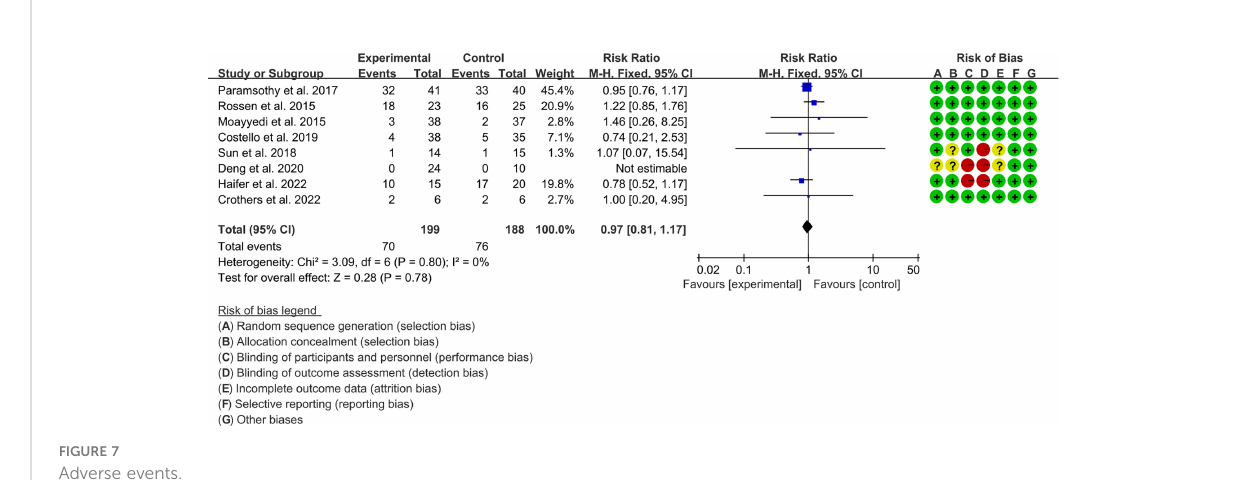
FIGURE 7 Adverse events.